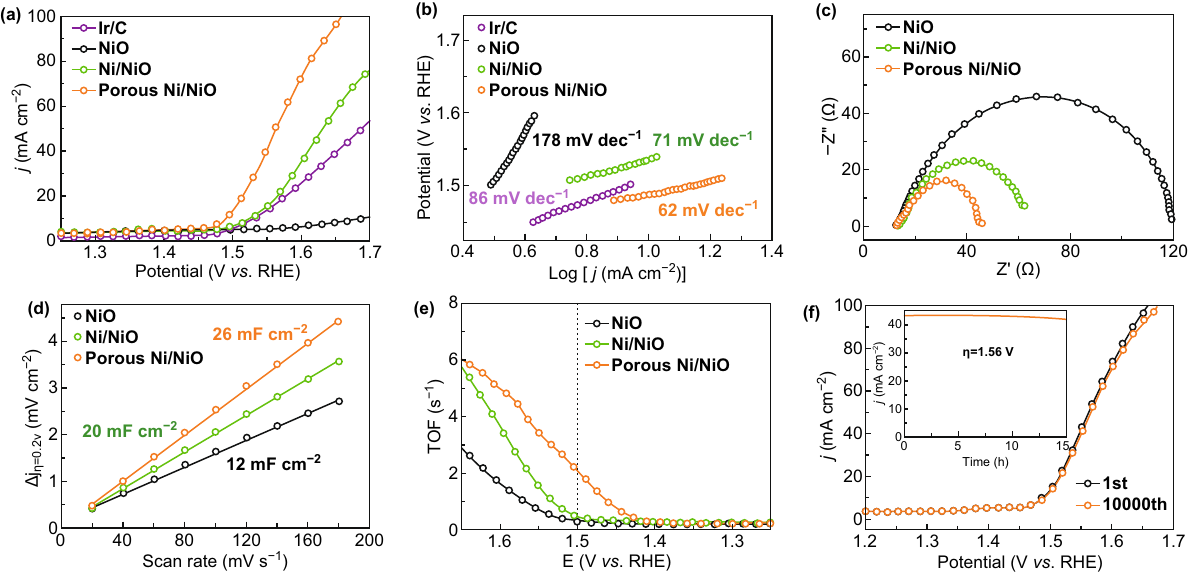
Fig. 3 a LSV polarization curves, b Tafel plots, c EIS, d ECSA, and e TOF data for NiO, Ni/NiO, and porous Ni/NiO catalysts. f LSV polariza- tion curves before and after 10,000 CV cycles for porous Ni/NiO catalyst. Inset shows the current density dependence as a function of time at ƞ = 1.56